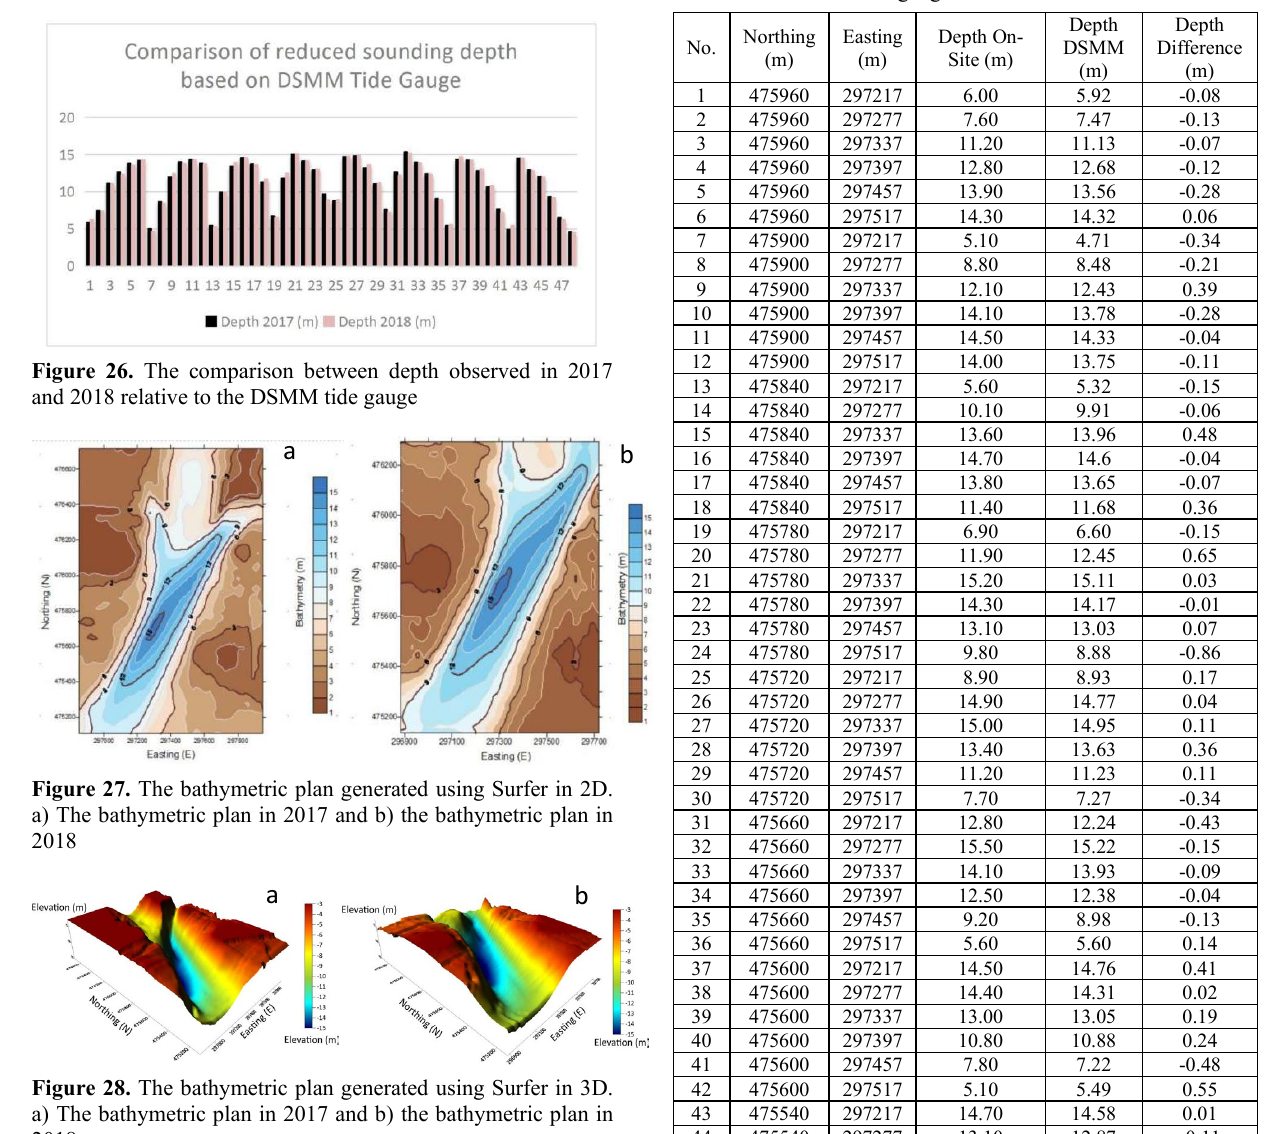
Table 5. Depth comparison of reduced sounding depth relative to on-site and DSMM tide gauge in